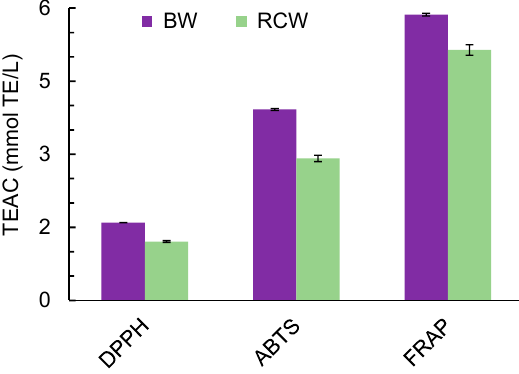
Figure 1. Trolox equivalent antioxidant capacity (TEAC) of bilberry waste (BW) and red currant waste (RCW) by the DPPH, ABTS and ferric reducing antioxidant power (FRAP) assays.